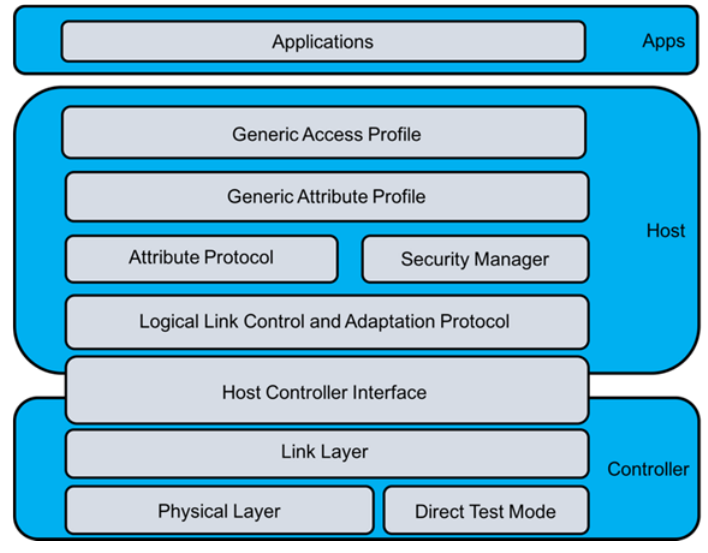
Figure 3. Bluetooth Protocol Stack (Bluetooth 4).